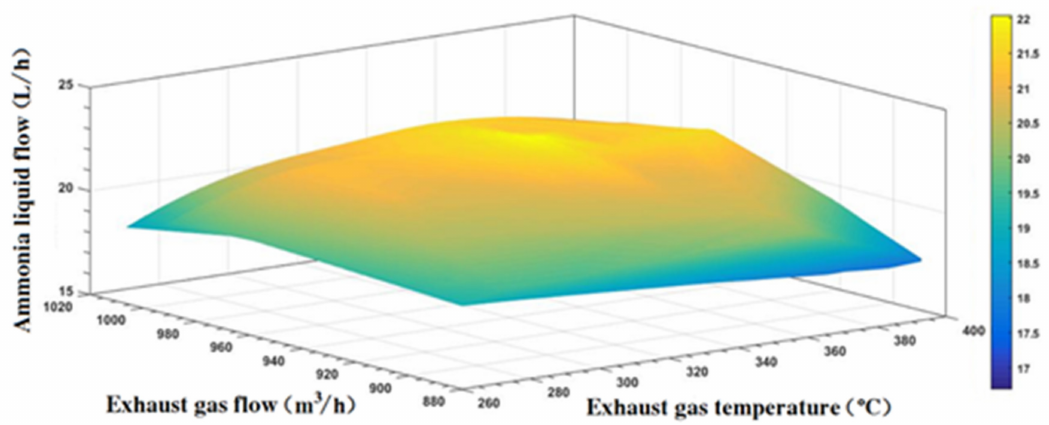
Figure 14. The relationship between the predicted liquid ammonia flow and exhaust